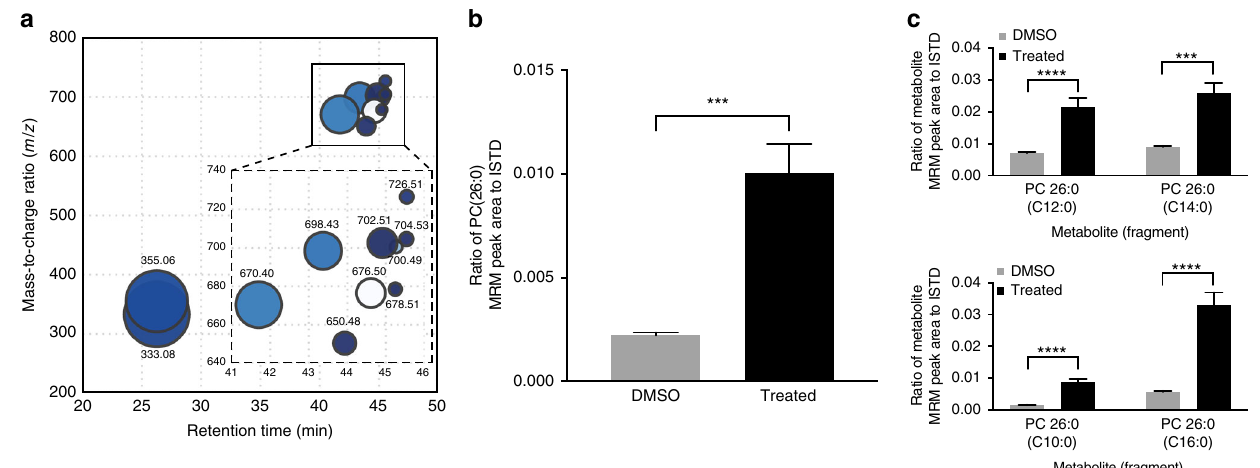
Fig. 7 Metabolomic pro fi ling of compound 4j in human cells. a SW620 cells were treated with 4j (2.5 µ M, 4 h) or DMSO and collected for metabolomic analysis. Untargeted metabolomics showed a number of signi fi cant metabolite changes ( p < 0.01) measured in positive ionization mode. Bubble sizes represent fold change, while increasing statistical signi fi cance is represented by darker shadings. The two bubbles at RT ≈ 26 min correspond to hydrogen or sodium adduct of a cellular metabolite of 4j (M = 4j – C 5 H 6 BNO 3 ). Several species in the expanded inset were deduced to be potential phosphatidylcholines (PCs) by mass-to-charge ratio and retention time. b Multiple reaction monitoring of PC-related transitions (M+H → phosphocholine) con fi rmed elevations in 26:0 PC in 4j -treated cells. c Negative mode fragmentation (M+HCO 2 − → RCOO − ) revealed PC(26:0) to be a mixture of PC (10:0 – 16:0) and PC(12:0 – 14:0) species. For b and c , the data represent average values ± S.E.M. values from fi ve independent experiments per group. Statistical signi fi cance was calculated with unpaired students t- tests comparing 4j -treated to DMSO-treated groups; *** p < 0.001; **** p <